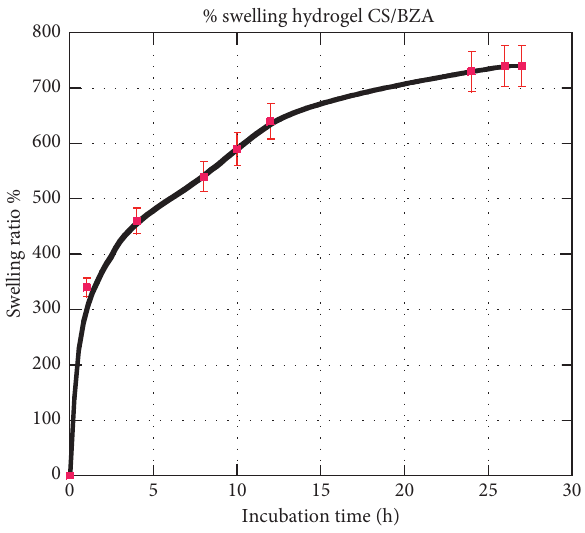
Figure 13: % swelling degree (SD).